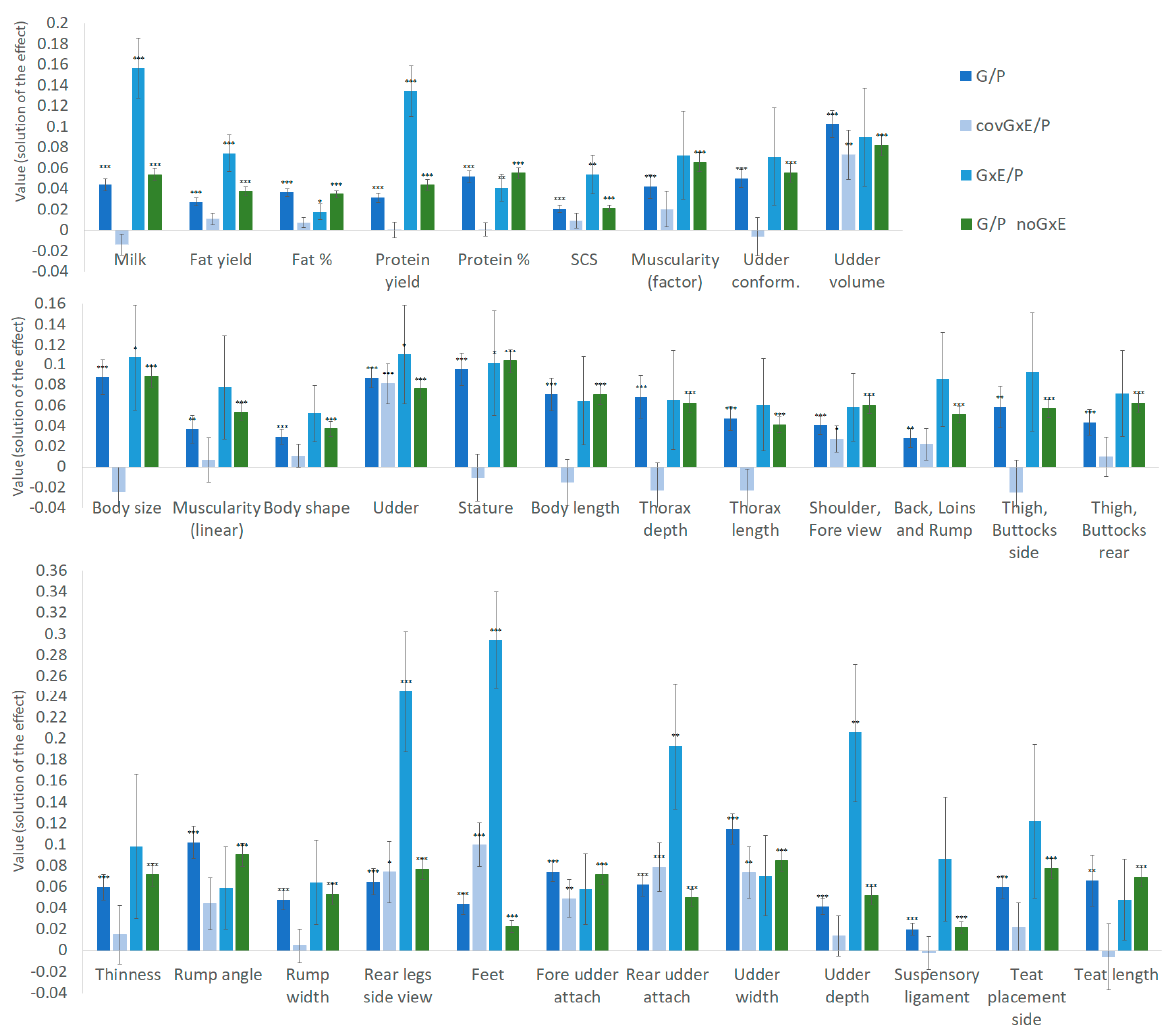
Figure 2. Proportion on phenotypic variance and its standard error for genetic (G), Genotype by Environment (GxE) components and their covariance (covG,GxE), each one expressed on the total phenotypic variance absorbed (P), for traits included in the study. The columns G/P, GxE/P and covGxE/P refer to the models including GxE, and G/E_noGxE to the models not including GxE. Significance of variance ( z -scores test): * = p ≤ 0.005; ** = p ≤ 0.01: *** = p ≤ 0.001.